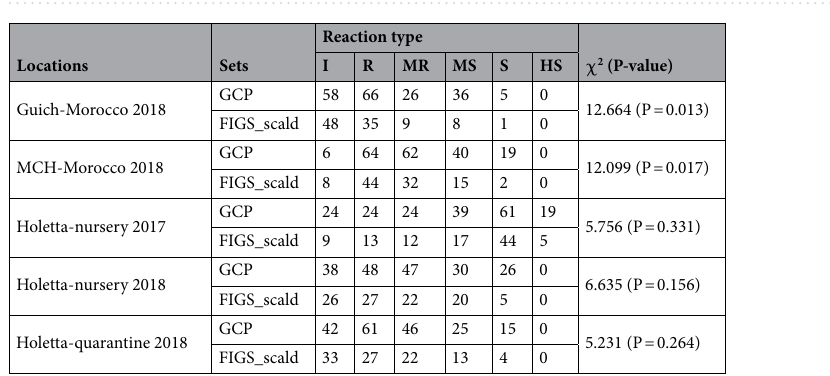
Figure 2. Adult plant reaction of GCP and FIGS barley subsets (in percent) to scald populations under field conditions. I–R Immune and resistant, MR moderately resistant, MS moderately susceptible, S susceptible, HS highly susceptible.